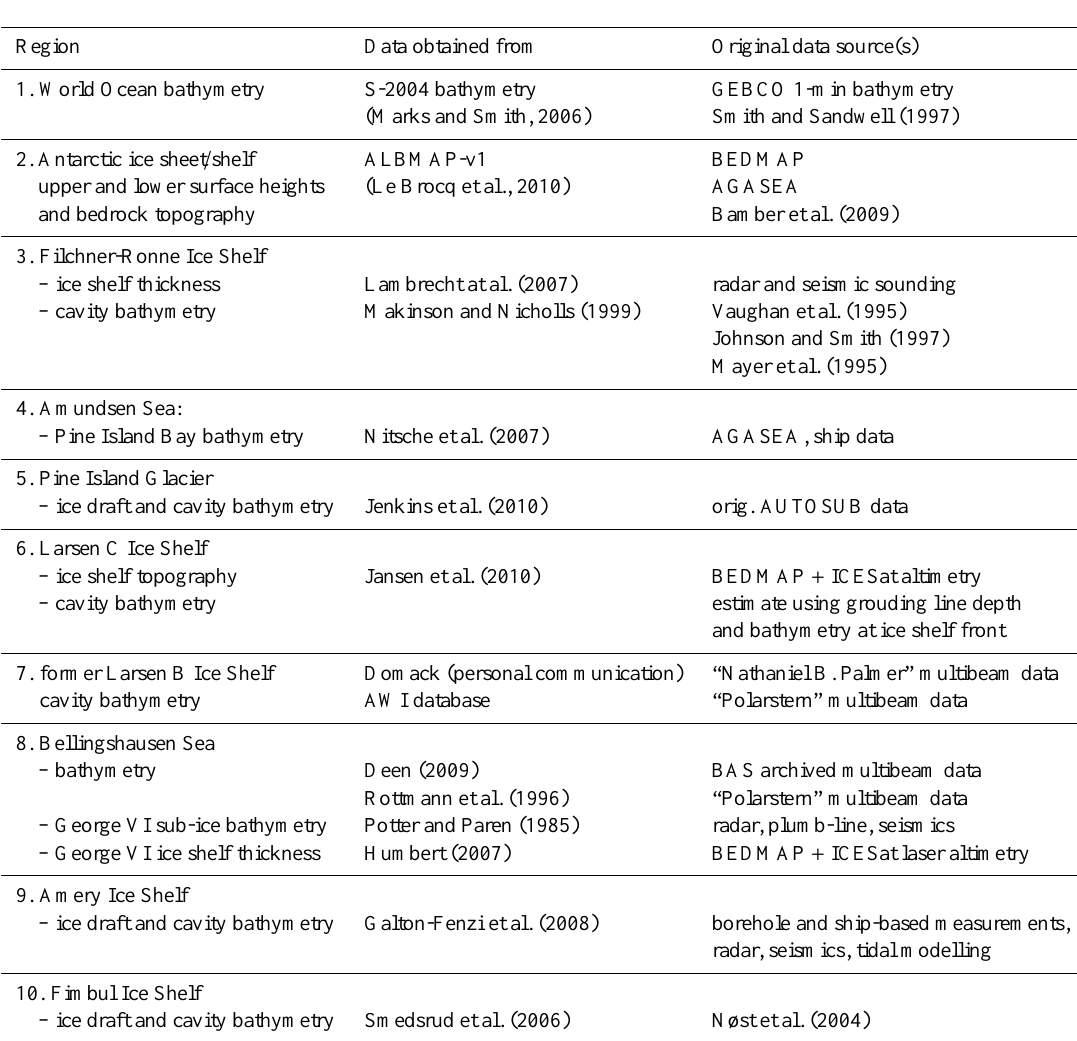
Table 1. Data sources for individual regions of the Southern Ocean, as merged into RTopo-1. Numbers in the Region column correspond to the source flag in Fig.